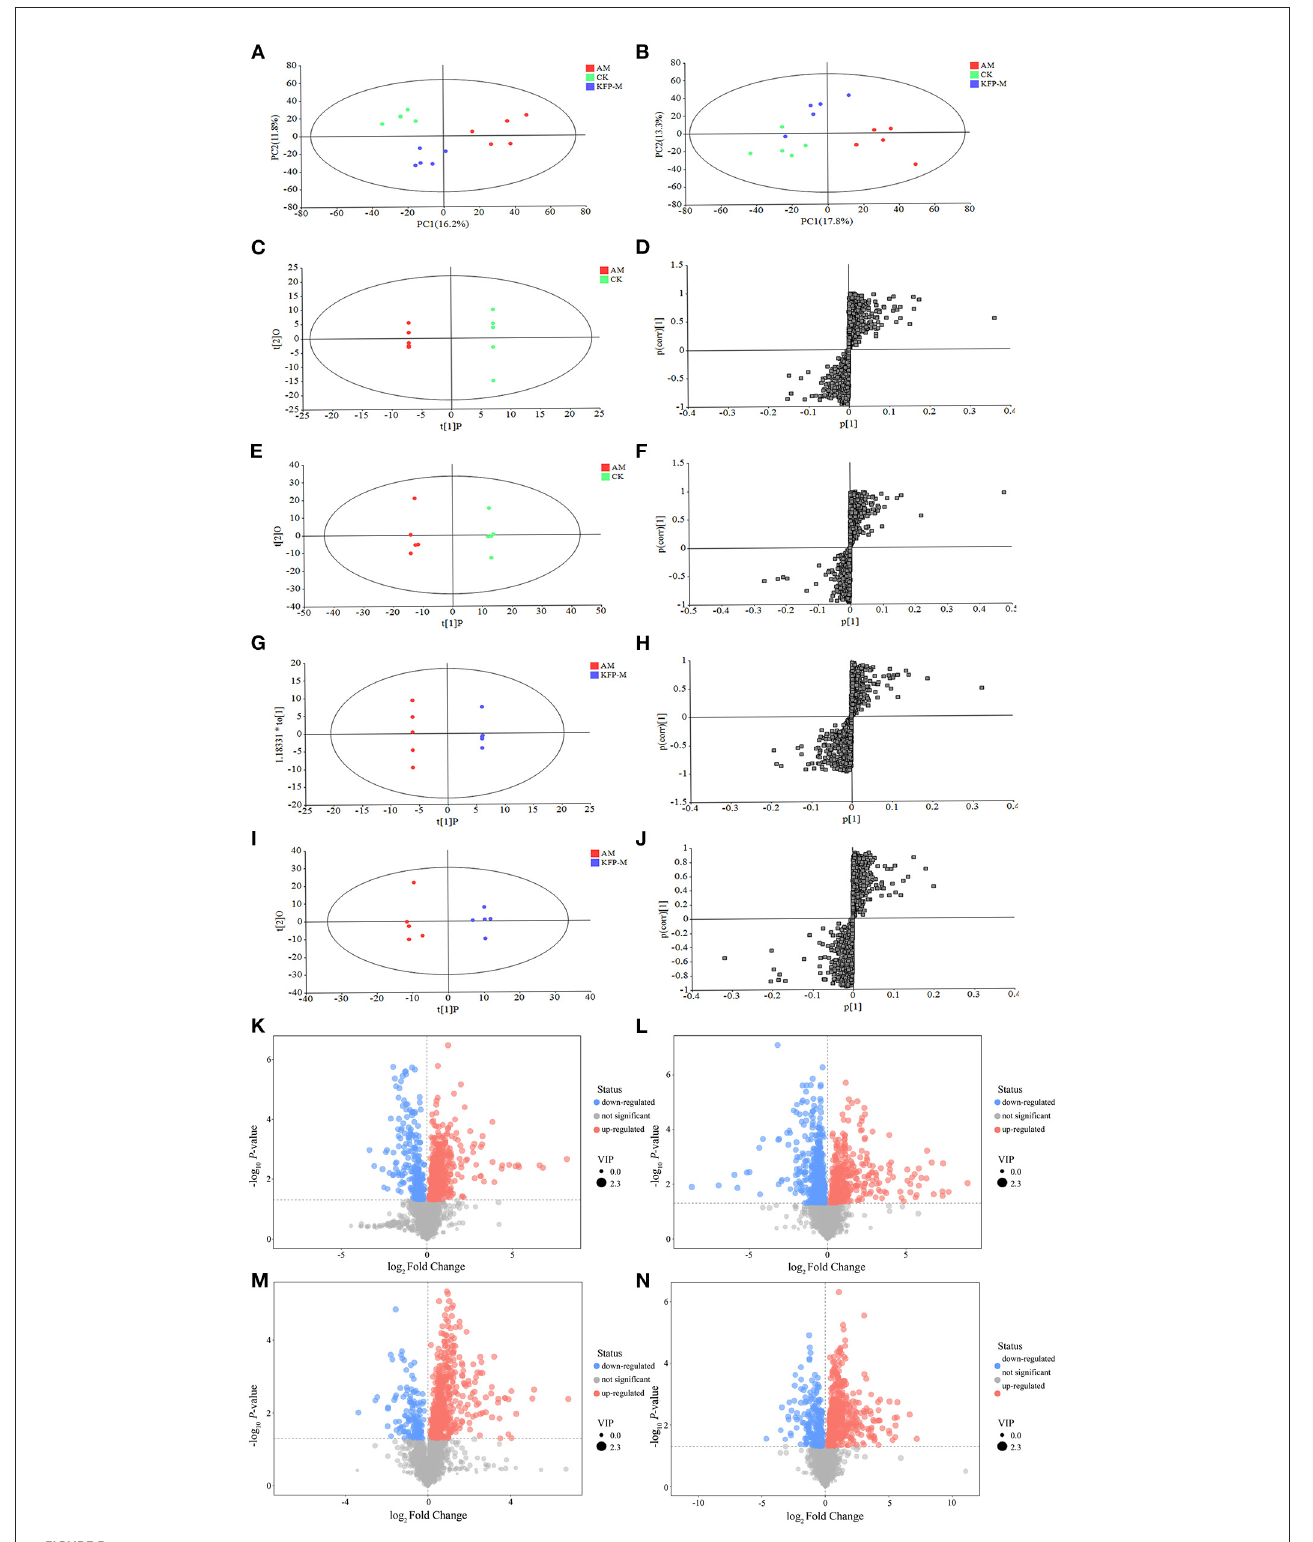
FIGURE5 PCA score plots of serum metabolic profiling in positive mode (A) and negative mode (B) . OPLS-DA score plots of serum metabolic profiling of AM and CK in positive mode (C) and negative mode (E) and OPLS-DA S-plots in positive mode (D) and negative mode (F) . OPLS-DA score plots of serum metabolic profiling of AM and KFP-M in positive mode (G) and negative mode (I) and OPLS-DA S-plots in positive mode (H) and negative mode (J) . Volcano plots of metabolites between CK vs. AM groups in positive mode (K) and negative mode (L) and AM vs. KFP-M in positive mode (M) and negative mode (N) . CK, control group; AM, acrylamide model group; KFP-M, medium-dose KFP group. Each group consisted of five